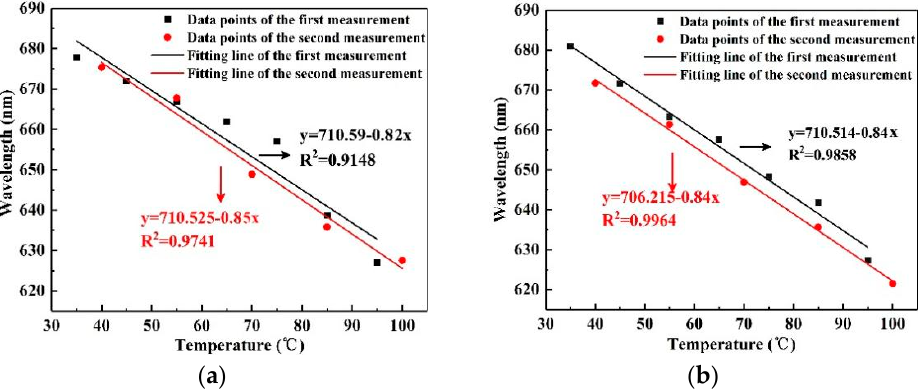
Figure 9. ( a ) The relation spectrum between wavelength and temperature in the heating process of the MSF sensor; ( b ) the relation spectrum between wavelength and temperature in the cooling process of the MSF sensor.